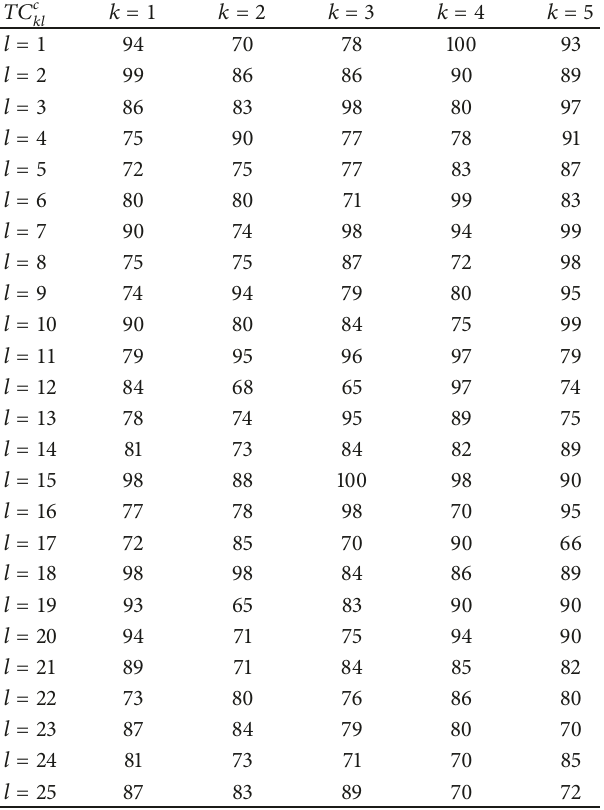
Table 6: Parameters of the base case, transportation unit cost from warehouses 𝑘 to retailer 𝑙